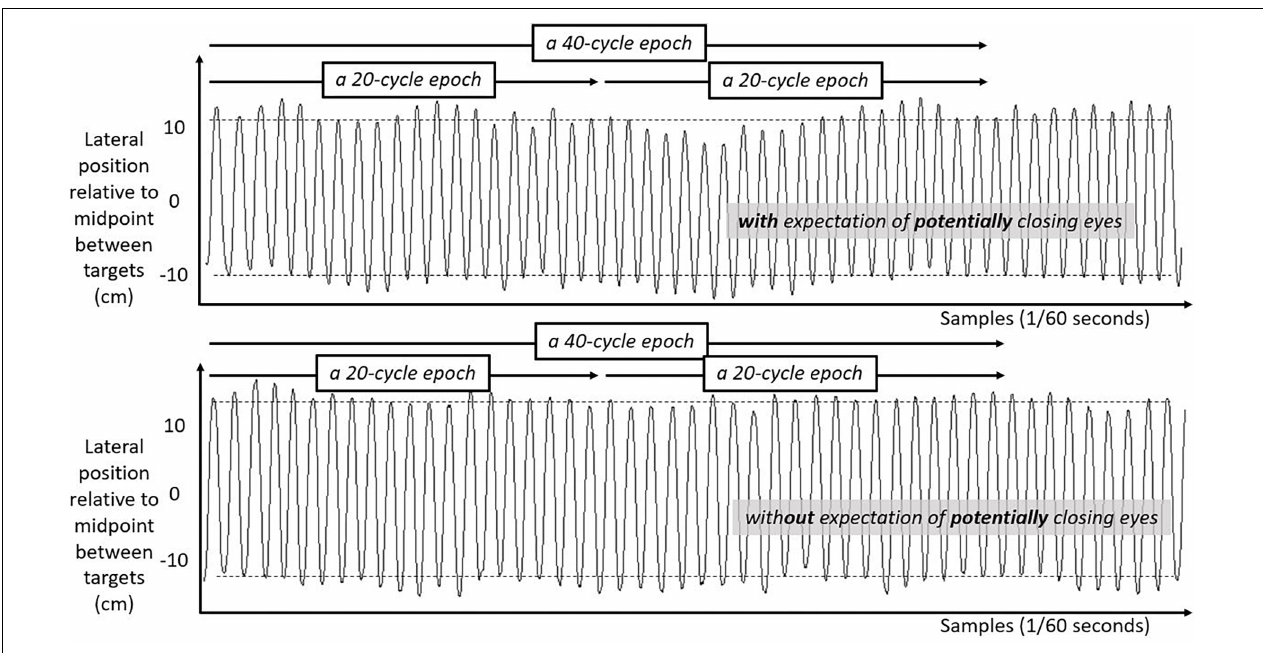
FIGURE 4 | Lateral hand position over time for 50 s in the first half of the task. Solid lines show the lateral position of the hand over time in the first half of the task for two participants both with their eyes open. Top panel shows movement series for a participant expecting that they might have to close their eyes later. Bottom panel shows movement series for a participant with no expectation of having to close their eyes later. Dashed horizontal lines schematize the average lateral position of manual contacts from which aiming variability SD(Aim) was